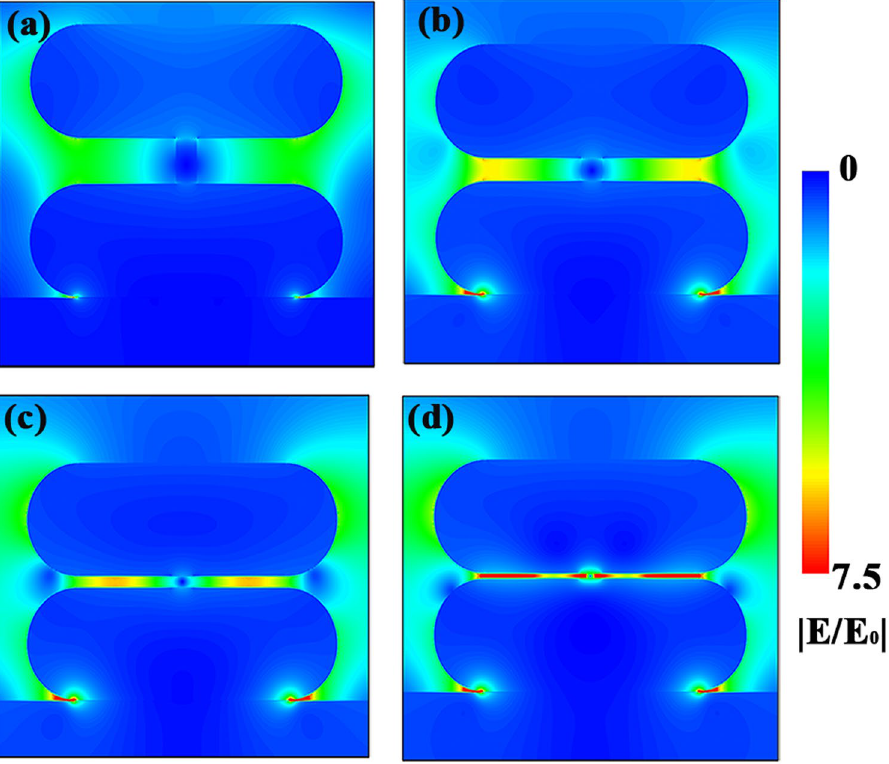
Figure 3. FDTD simulated electric field distribution of Au NPs/nanogap/Au NPs with various gap sizes: ( a ) 20, ( b ) 10, ( c ) 5, and ( d ) 2